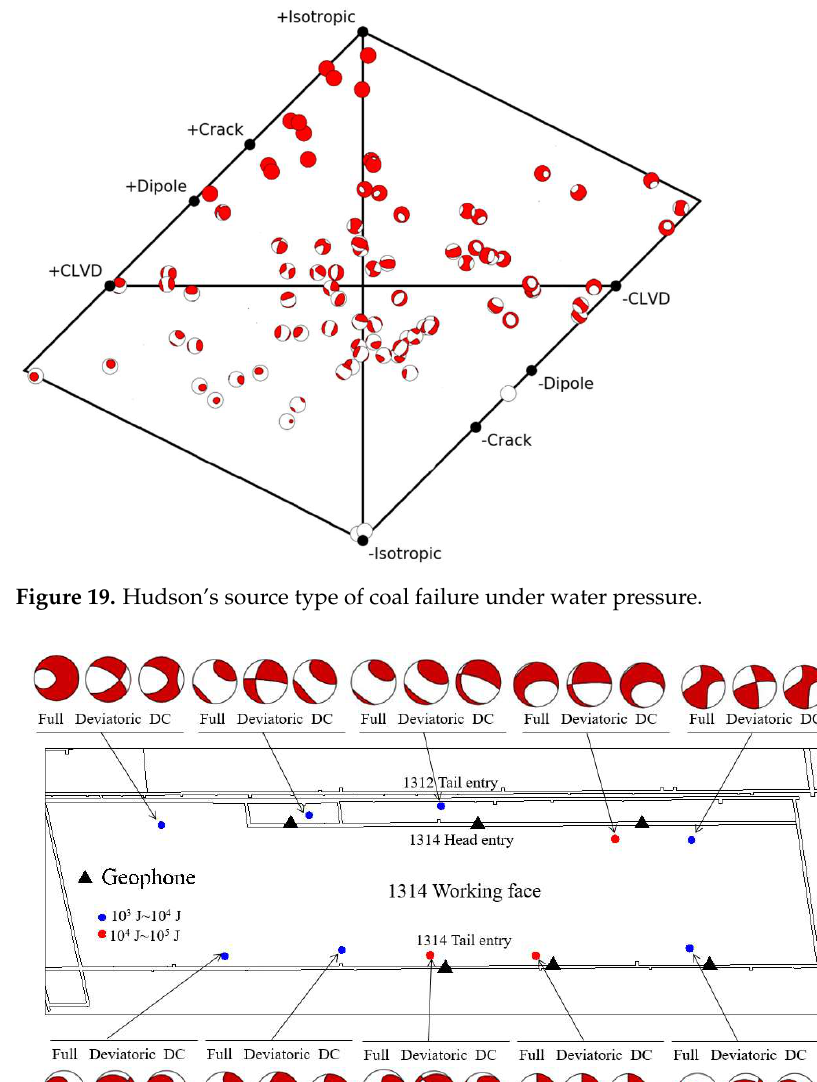
Figure 19. Hudson’s source type of coal failure under water pressure.